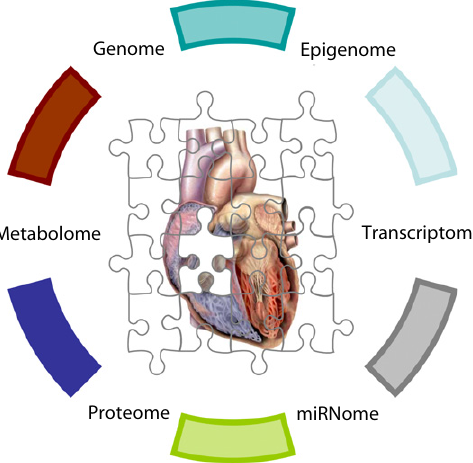
Figure 14. To fully unravel the intricate pathways regulating cardiac physiology and pathophysiology the global studies of the human genome will need to be extended to similar studies at the epigenome (chemical changes to the DNA and histone affecting the chromatin structure and function of the genome), transcriptome (the full set of transcripts produced fromthe human DNA), miRNome (the full set of microRNAsproduced from the human DNA), proteome (the full set of proteins) and metabolome (full set of metabolites)